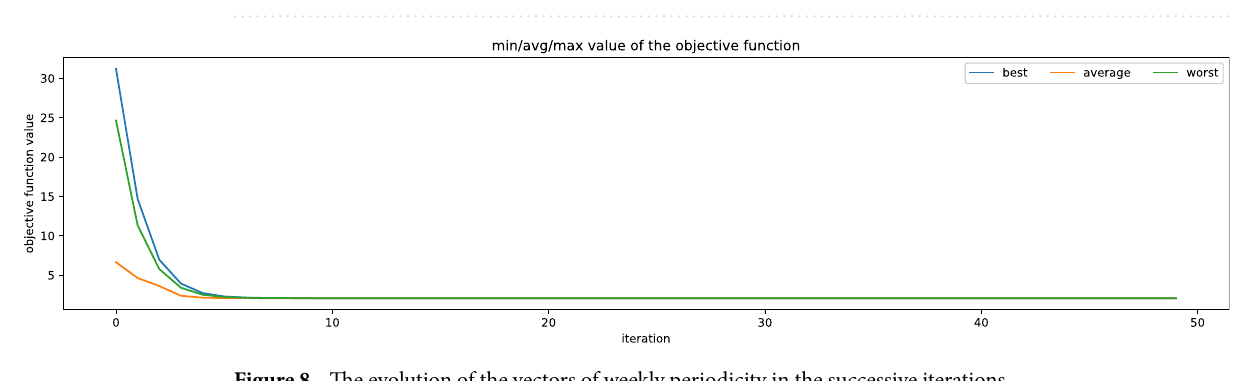
Figure 7. Weekly periodicity vector of water demand.